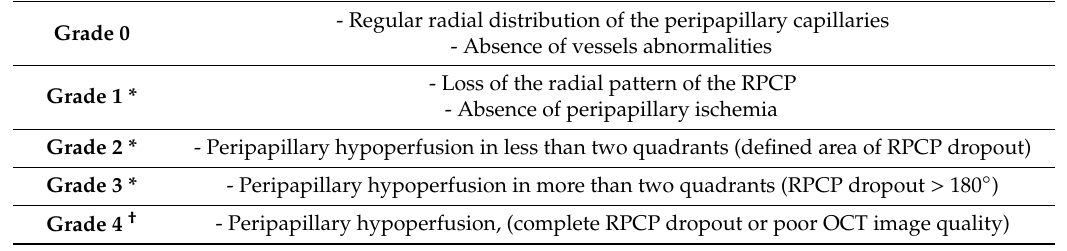
Table 3. Clinical classification of radiation optic